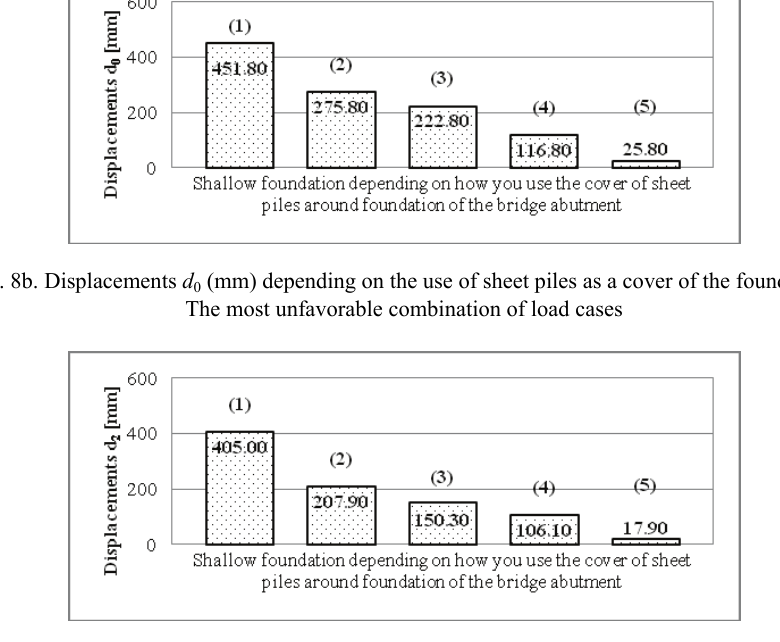
Fig. 8c. Displacements d 2 (mm) depending on the use of sheet piles as a cover of the foundation. The most unfavorable combination of load cases